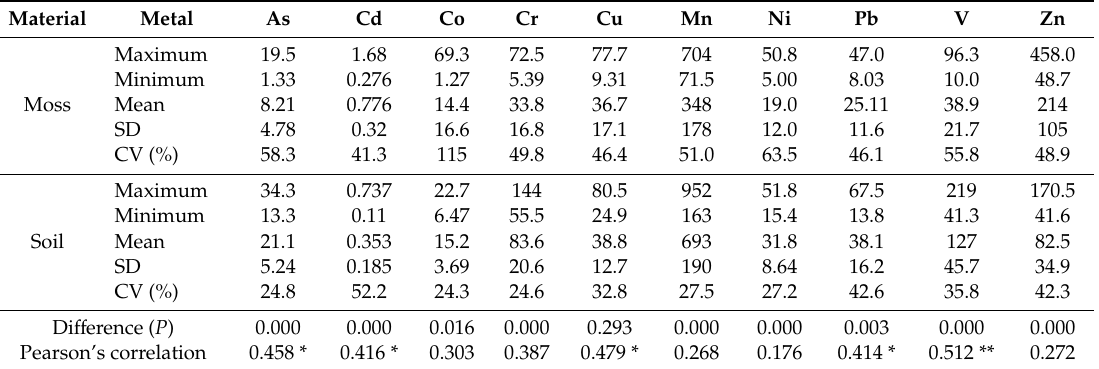
Table2. Traceelementconcentrations(mgkg -1 )inmoss Haplocladiumangustifolium andthesubstratesoil. Material